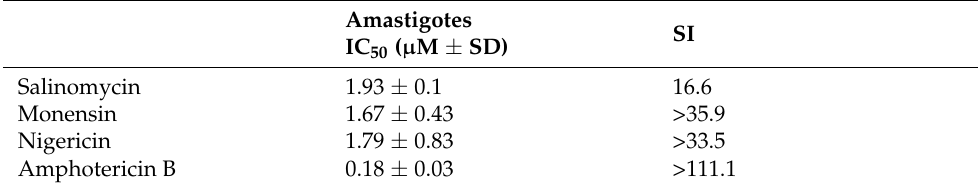
Table 3. Antiparasitic activity against L. infantum intracellular amastigotes and selectivity index of